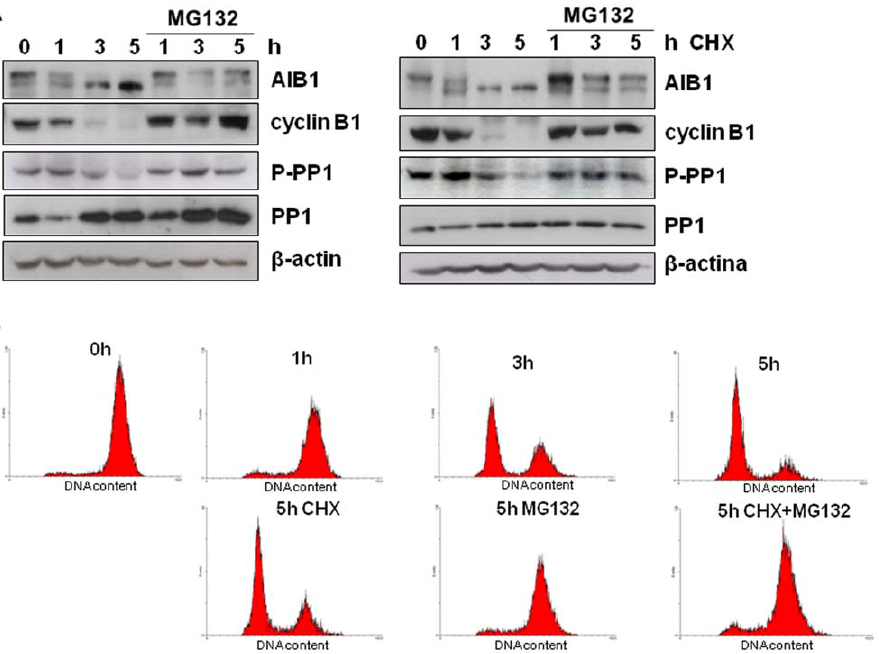
Figure 6. Desphosphorylation of AIB1 occurs at mitosis exit. (A) Floating MCF7 cells arrested at mitosis with nocodazole were washed and liberated to progress through mitosis for the times indicated, in the presence or absence of 20 m M MG132 and 10 m g/ml cycloheximide (CHX). Western blot analysis was performed for AIB1 to monitor its phosphorylation status. Cyclin B1, protein phosphatase 1 (PP1), and the inhibitory phosphorylation of PP1 (P-PP1) were also assessed. b -actin was used as a loading control. (B) Flow cytometry analysis of MCF-7 cells treated as above was used to confirm cell-cycle progression as determined by DNA content.